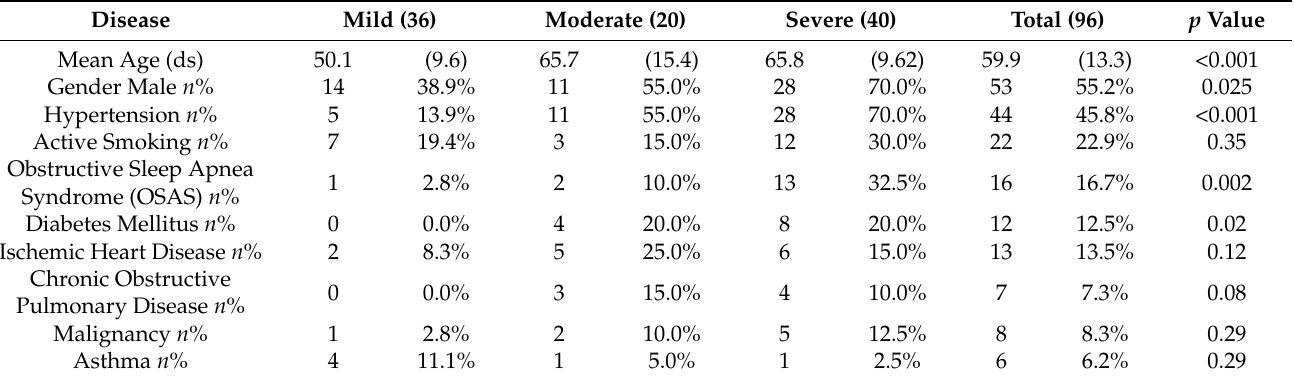
Table 1. Demographic data and comorbidity of 96 Italian patients clustered on the basis of COVID-19 severity classification in line with Chen and colleagues